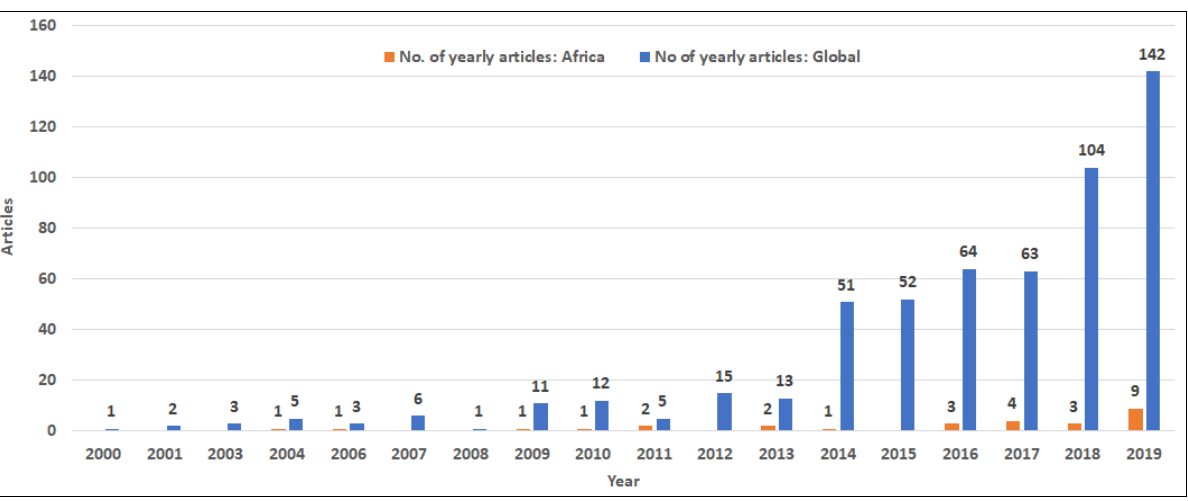
Annual scientific publication output, globally and from